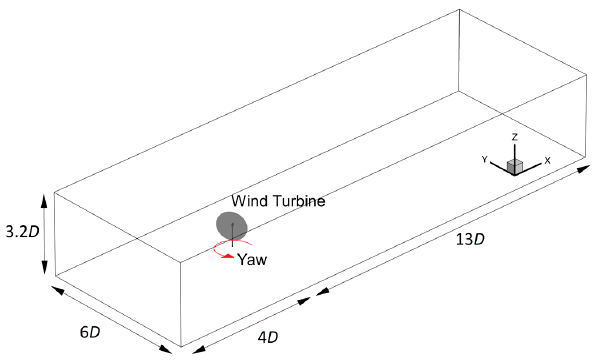
Figure 3. Schematic view of the computational domain.